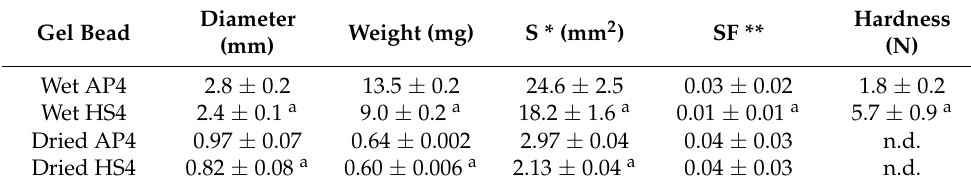
Figure 1. Photographs of wet AP4 ( A ), HS4 ( C, ) and dried AP4 ( B ), HS4 ( D ) gel beads. Table 1. Characterization of gel beads.